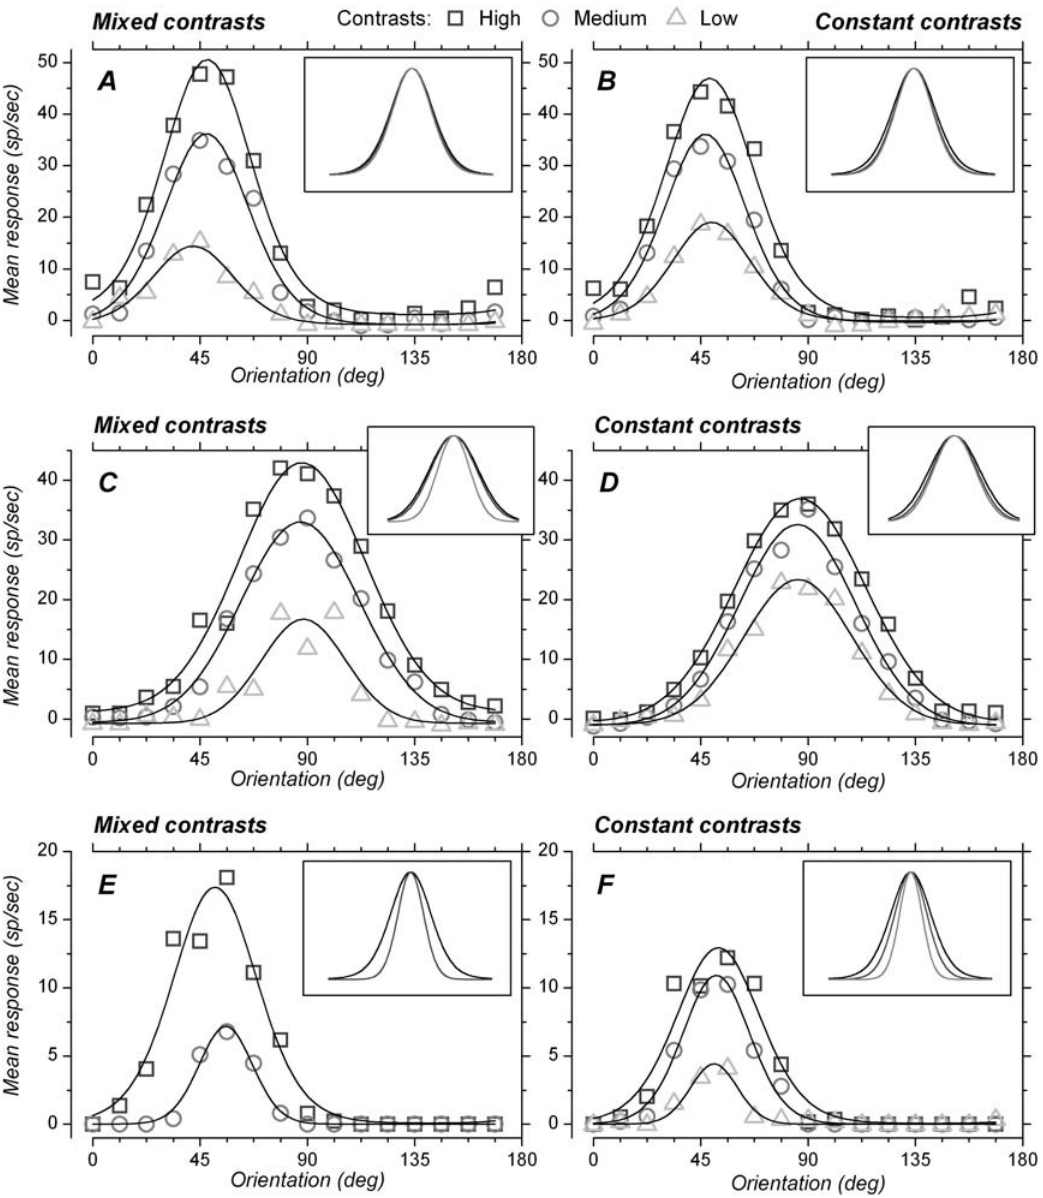
Figure 3. Orientation tuning with different contrasts in mixed and constant contrast blocks, additional examples. Symbols represent the mean firing rate for each orientation and contrast, and the lines correspond to the von Mises (A, B, E, F) or Gauss (C, D) equations fitted to the orientation-response data. Inset shows fitted lines normalized to the same preferred orientation and to the same height, to facilitate comparison of tuning widths. A. For this cell, contrast, in the mixed contrasts condition, had little effect on orientation tuning width, although response amplitude depended strongly on contrast. Contrasts were 11.3, 16 and 22.6%. HWHH were 20.1, 21.1 and 21.9 deg for low, medium and high contrasts, respectively. B. For the same cell, orientation tuning width was also little affected by contrast in the constant contrast blocks. HWHH were 19.3, 20.2 and 22.4 deg for low, medium and high contrasts, respectively. C. This cell showed, in the mixed contrasts condition, reduced tuning width with low contrast stimuli compared to high or medium contrast stimuli. Contrasts were 22.6, 32 and 64%. HWHH were 20.7, 29.2 and 31.2 deg for low, medium and high contrasts, respectively. D. After matched adaptation (constant contrast), the range of HWHH appears to be less wide. HWHH were 26.7, 28.7 and 32.1 deg for low, medium and high contrasts, respectively. E. No significant response was obtained in this cell with low contrast stimuli (35%) in the mixed contrasts block. The tuning curve obtained with high contrast (90%) was broader (HWHH: 20.9 deg) than the tuning curve obtained with medium contrast (50%, HWHH: 13.2 deg). F. Despite adaptation to matched contrasts, the same cell shows differences in HWHH between low (11.6 deg), medium (16.6 deg) and high (20.85 deg) contrasts.